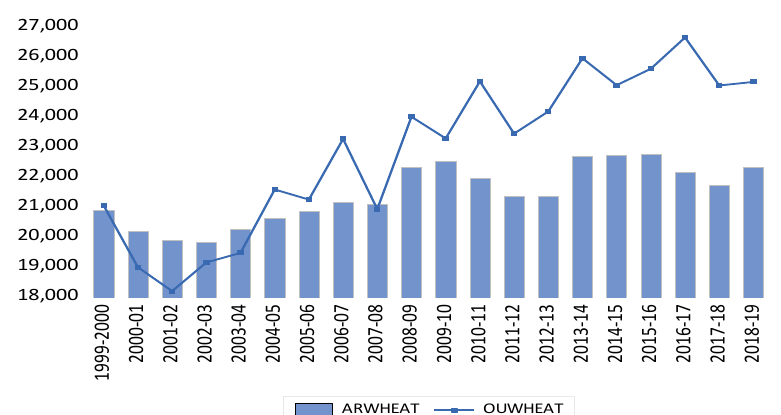
Figure 1: Area and yield of wheat crops,